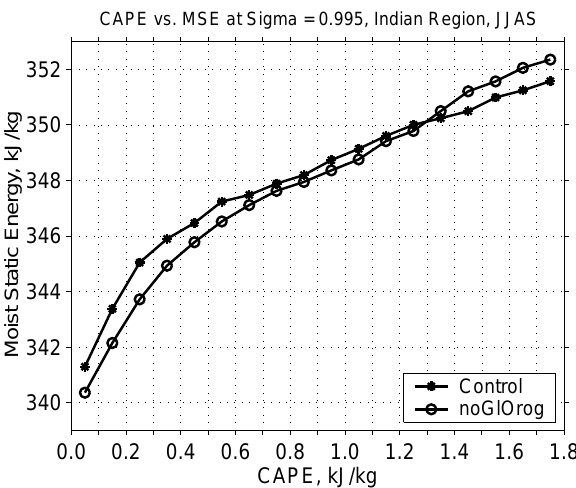
Fig. 3. Relation between convective available potential energy (CAPE) and surface moist static energy (SMSE, the moist, static energy at the model’s bottom most sigma layer: σ =0.995) over the Indian region from the control and noGlOrog simulations. CAPE values were grouped at 0.1kJkg − 1 bins and all the SMSE values corresponding to those grids were averaged for clarity of presenta- tion. The rate of increase of SMSE with CAPE is higher for SMSE values below 346kJkg − 1 (CAPE < 0.4kJkg − 1 ) as compared to the rate when SMSE is higher than 346kJkg − 1 . Note that this relation- ship between CAPE and SMSE is independent of the presence of orography.